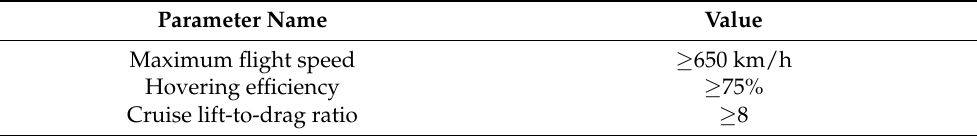
Table 9. The performance requirements of the distributed eVTOL.